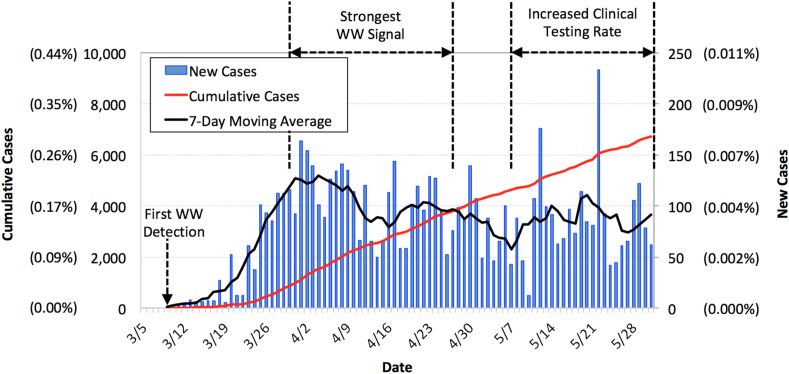
Clinically confirmed COVID-19 case data for Southern Nevada (SNHD, 2020). New cases were assigned based on when data were reported to the Southern Nevada Health District (SNHD) and not based on symptom onset. Numbers in parentheses indicate case data relative to an overall population of approximately 2.3 million people. A statewide closure of non-essential businesses was ordered on March 17th, phase 1 reopening began on May 9th, and phase 2 reopening began on May 29th.